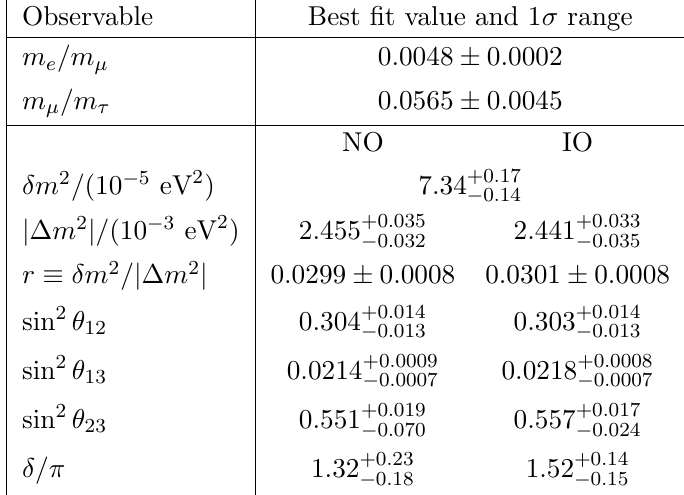
Table 3. Best (cid:12)t values and 1 (cid:27) ranges for neutrino oscillation parameters, obtained from the global analysis of ref. [2], and for charged lepton mass ratios, given at the scale 2 (cid:2) 10 16 GeV with the tan (cid:12) averaging described in [7], obtained from ref. [16]. The parameters entering the de(cid:12)nition of r are (cid:14)m 2 (cid:17) m 2 (cid:0) m 2 and (cid:1) m 2 (cid:17) m 2 (cid:0) ( m 2 + m 2 ) = 2. The best (cid:12)t value and 1 (cid:27) range of (cid:14) 2 1 3 1 2